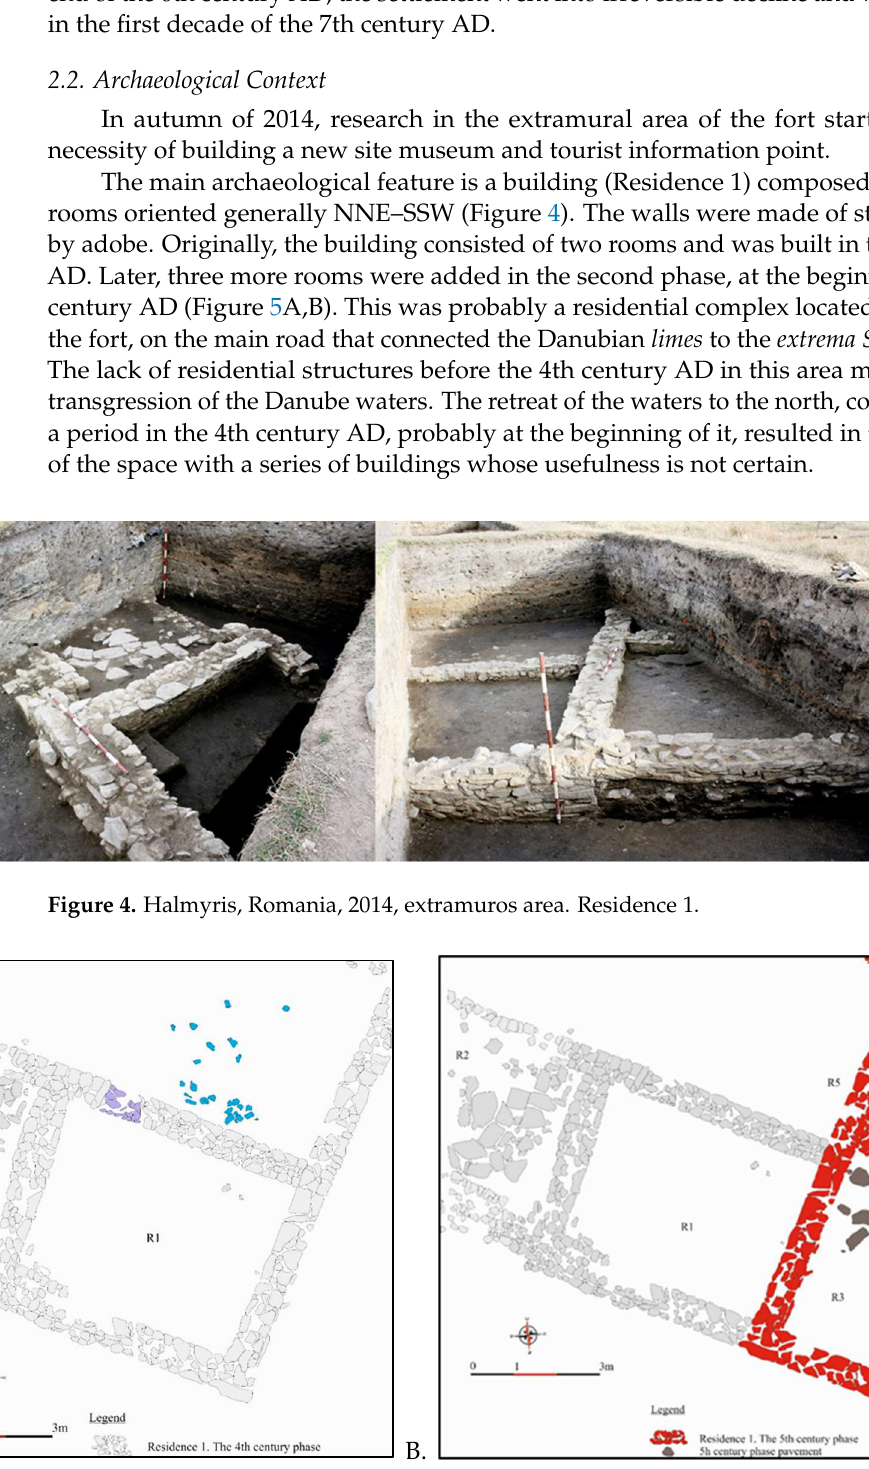
Figure 5. Halmyris, Romania, 2014, extramuros area (R1 – room 1; R2 – room 2; R3 – room 3; R4 – room 4; R5 – room 5). Residence 1. ( A ) North wing (4th century). ( B ) South wing (5th century phase). Purple: entrance; blue: remains of a pavement; grey: 4th-century phase; red: 5th-century phase and associated pavement (brown).